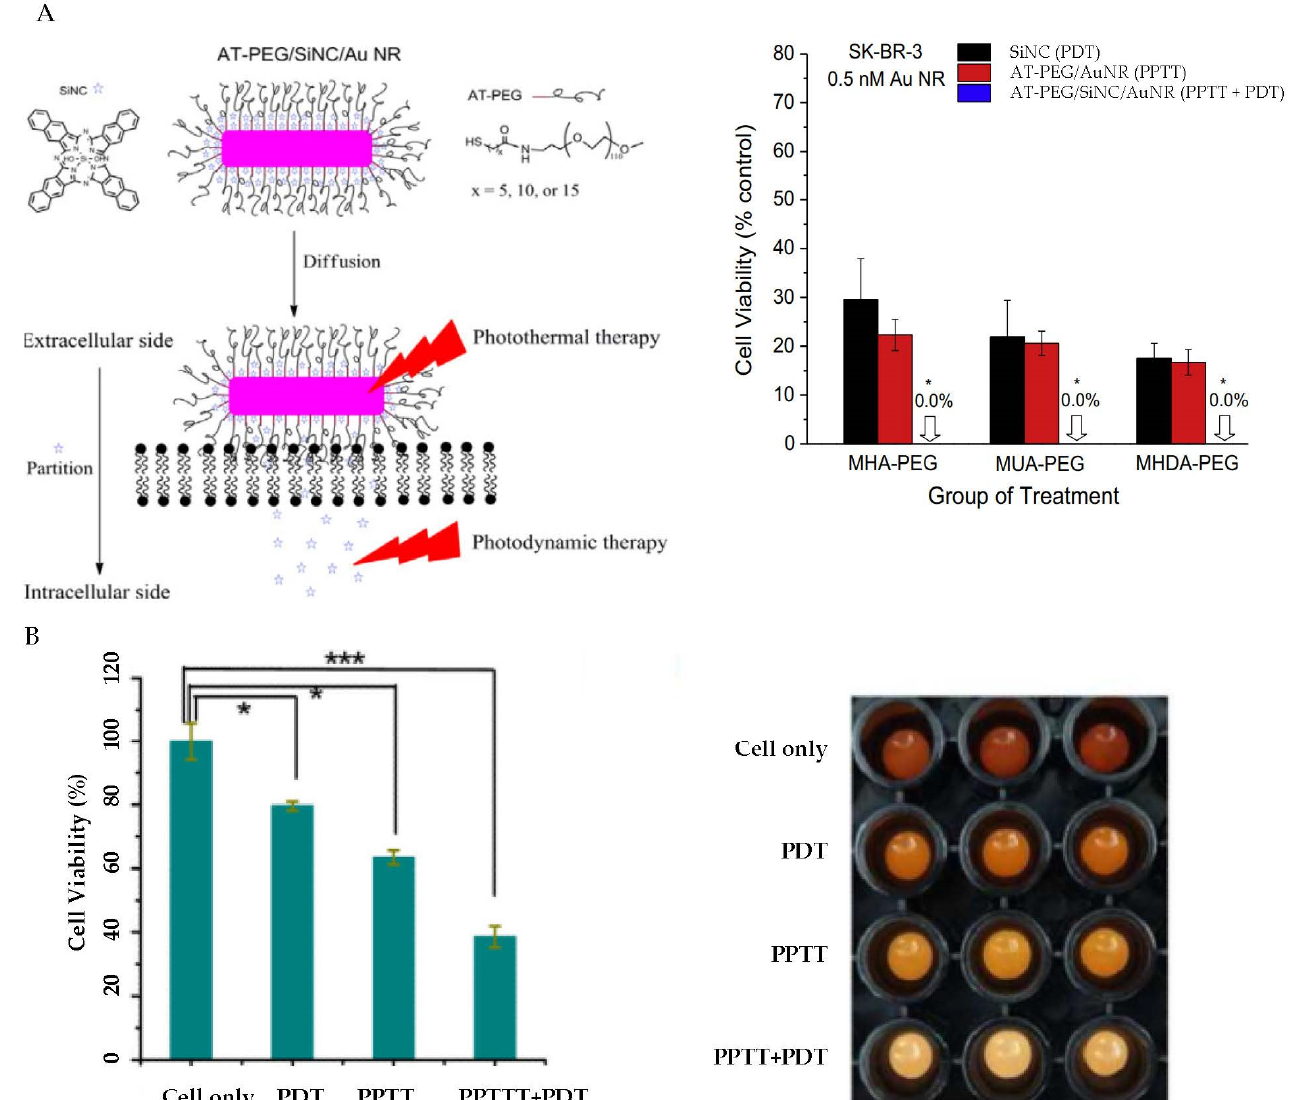
Figure 5. PPTT + PDT using AuNRs. ( A ) AT-PEG/SiNC/AuNRs for PPTT + PDT. Left : Schematic of the structure of AT-PEG/SiNC/AuNRs and mechanism of PPTT + PDT. Right : Comparison of SK-BR-3 cell viability data under different treatments. Reprinted/adapted from Ref. [139]. * indicates significant difference at p < 0.05. Copyright@2016, Elsevier. ( B ) Ce 6 -ASP-T 32 - NRs for PPTT + PDT. Comparison of CCRF-CEM cell viability data ( left ) and imaging under different treatments. * and *** indicates significant difference at p < 0.05 and p < 0.0001, respectively. Reprinted with permission from Ref [142], Copyright © 2012, American Chemical Society.